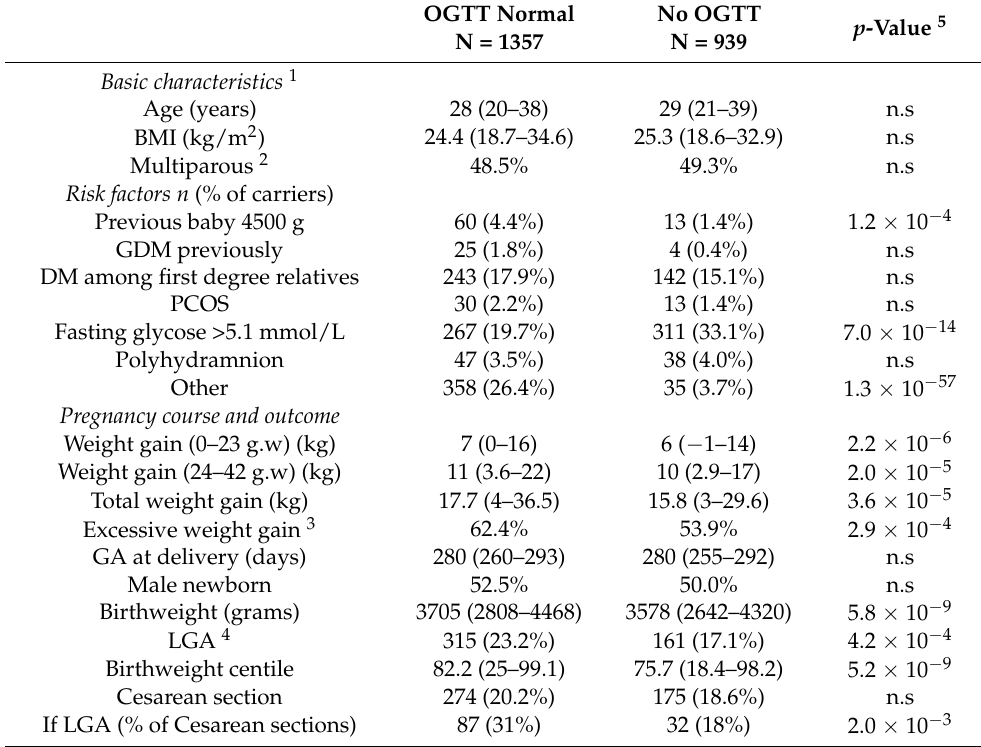
Table 5. Maternal characteristics and pregnancy course among high-risk pregnant women without GDM